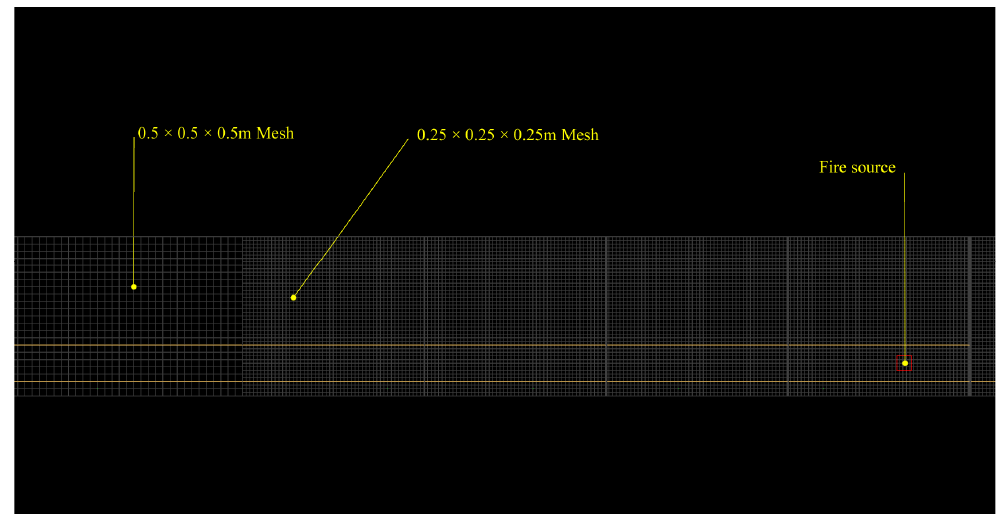
Figure 3. Grid meshes and fire source. The medium grid of 0.5 m was used for the majority of the tunnel, while the fine mesh of 0.25 was used near the field of the fire.